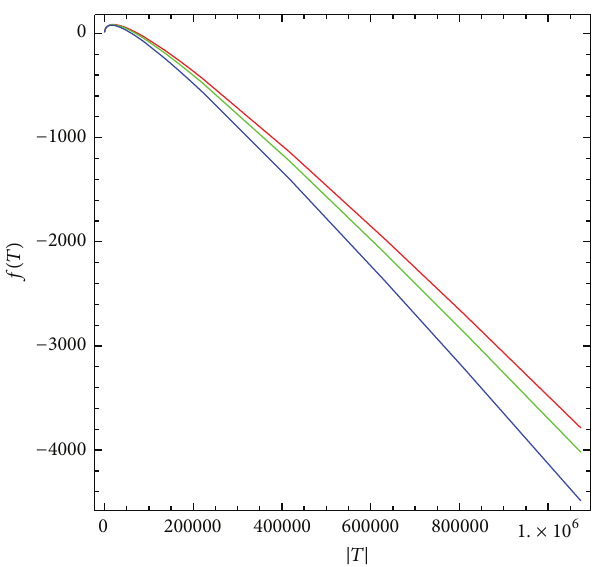
Figure 3: Deceleration parameter as in (37).